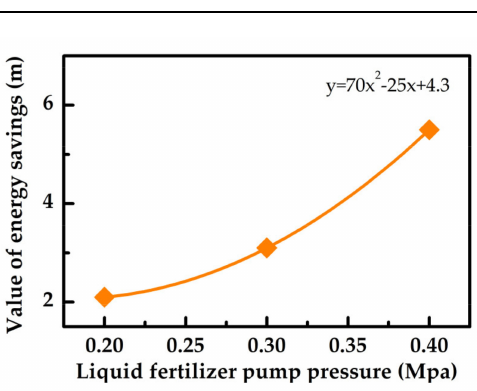
Figure 12. Relationship between energy saving and liquid fertilizer pump